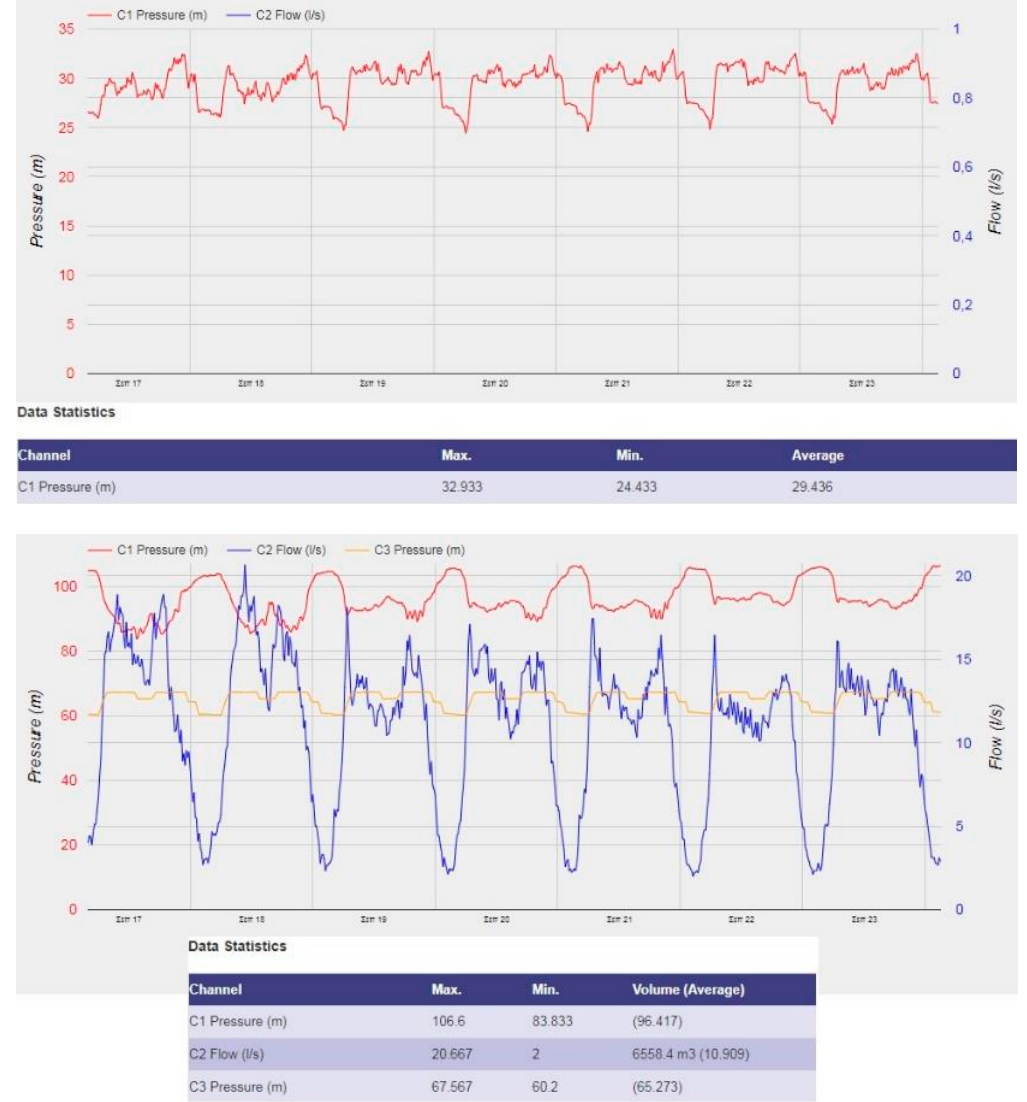
Figure 5. Weekly set of data from the 17th to the 24th of September